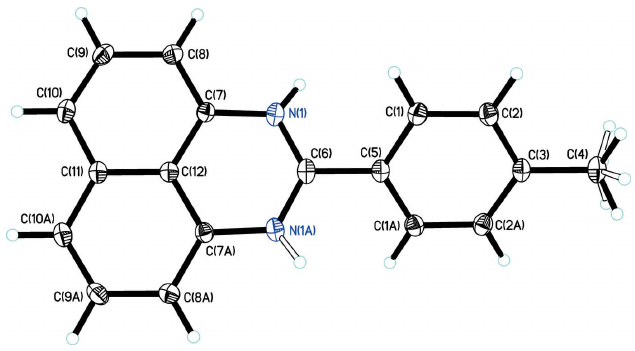
Figure 1 Molecular structure of 1- H -2-( p -tolyl)-perimidine ( 1 ), with displacement ellipsoids drawn at the 50% probability level. H atoms attached to N1 and N1 A are present at half occupancy by virtue of the forced twofold symmetry. [Symmetry code: (A) (cid:5) x + 5